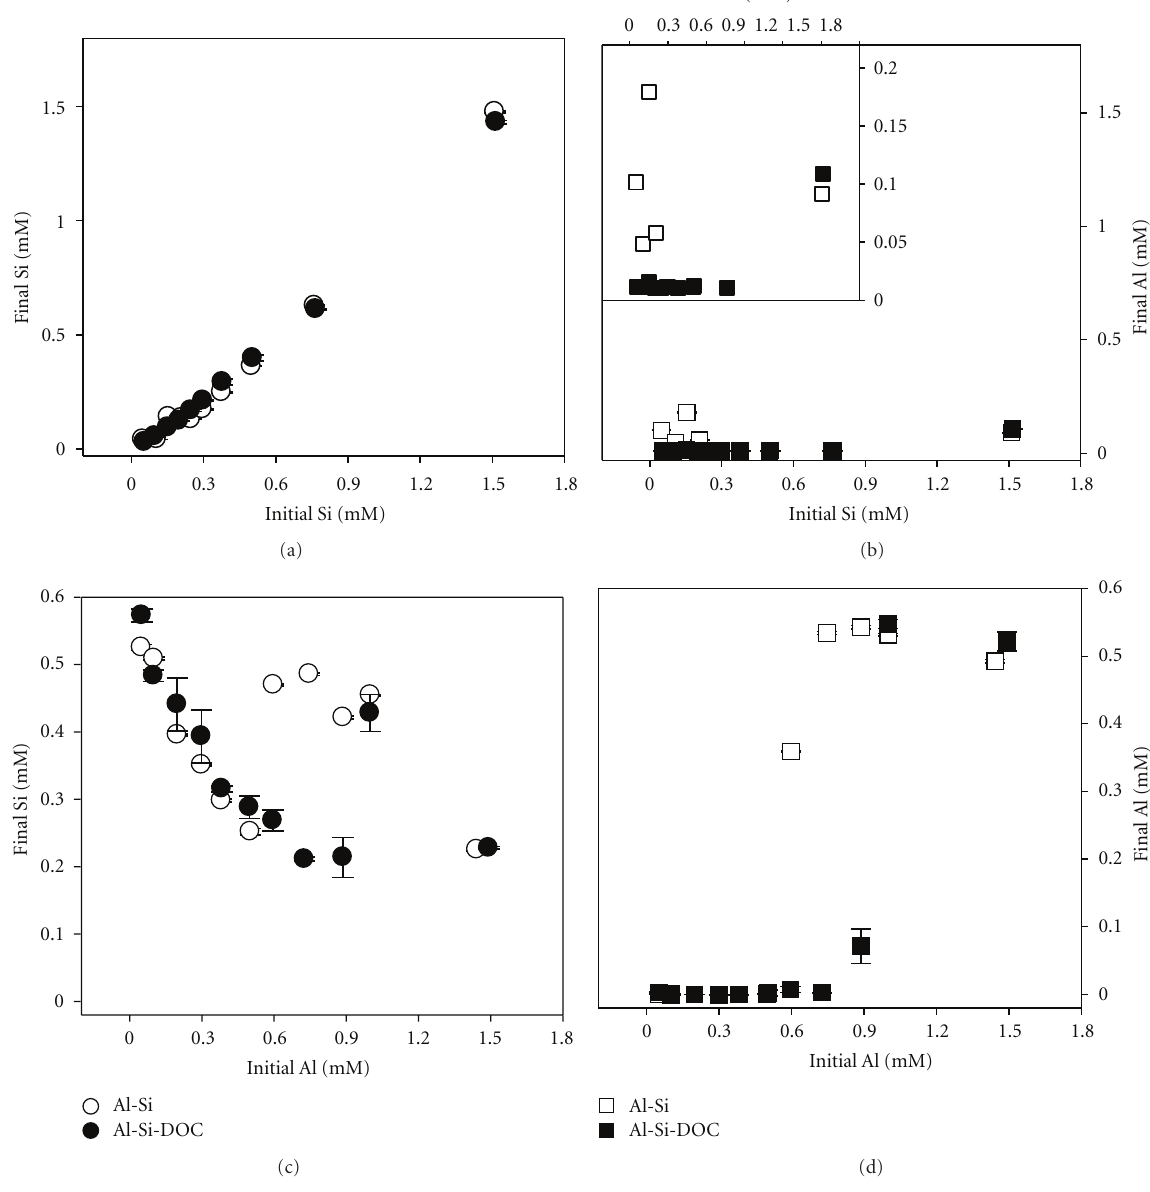
Figure 2: Final concentrations of (a) Si and (b) Al for 0.05–1.5 mM Si, 0.3 mM Al; (c) Si and (d) Al at 0.05–1.5 mM Al, 0.5 mM Si; in Al-Si (0mg/L DOC) and Al-Si-DOC (6mg/L DOC)